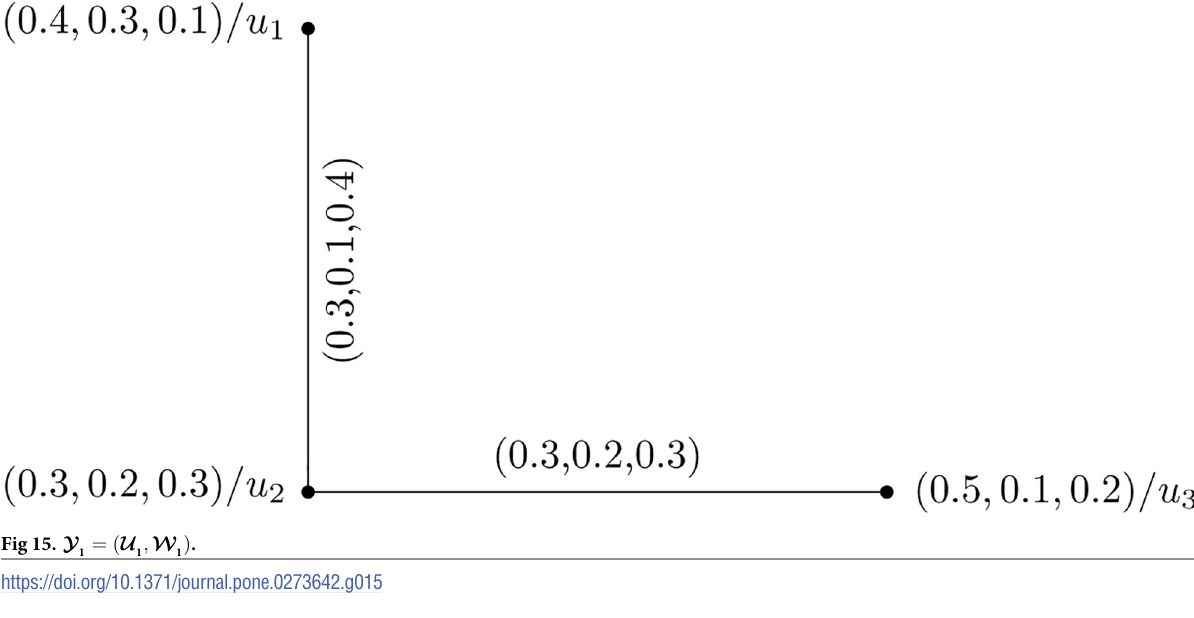
¼ ð U ; W Þ . 1 1 1